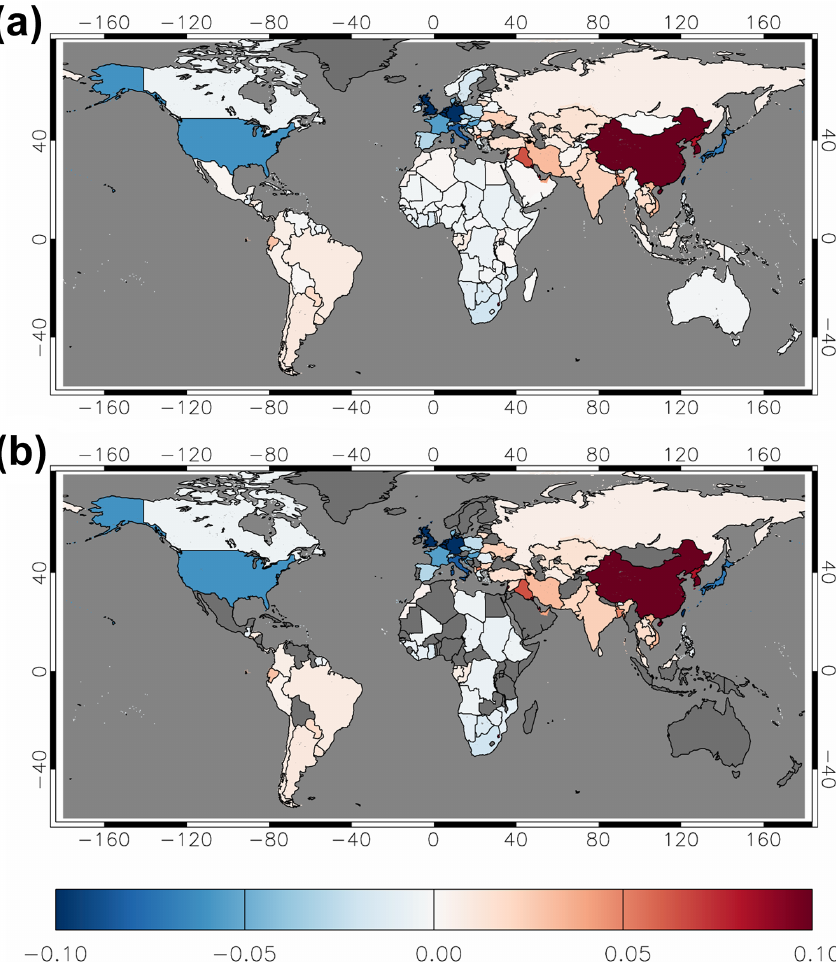
Figure 6. (a) Satellite-based trends of tropospheric NO 2 VCD (in 10 15 moleculescm − 2 yr − 1 ) on a country basis for the period April 1996– September 2017. Only trends calculated for time series with at least 8 months per year are taken into consideration; (b) same as (a) but for statistically significant trends at the 95% confidence